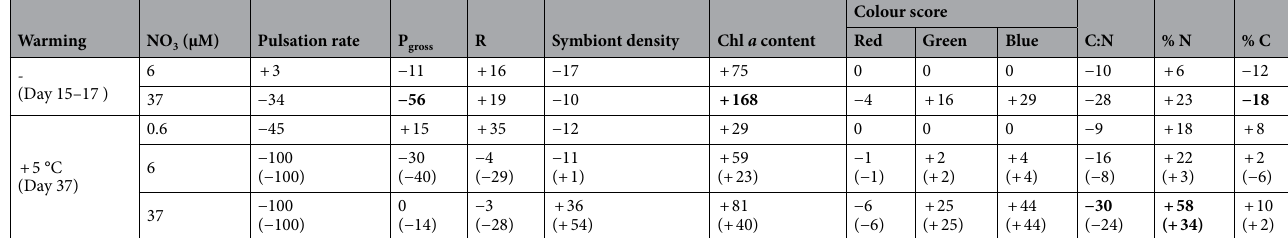
nitrate eutrophication treatment (MN + W) after 15 days (Fig. 3a and Table 1; pwc, Bonferroni adjustment, Dunn’s test, p < 0.05), but they did not significantly differ from controls. On day 22, after additional warm- ing, pulsation rates of colonies exposed to high nitrate eutrophication decreased by 97% compared to controls (at 28.4 °C). With medium nitrate eutrophication (MN + W), pulsation rates remained stable until day 28 (at 30.5 °C) and dropped to zero during the last week of the experiment (at > 30.6 °C). At the end of the experi-